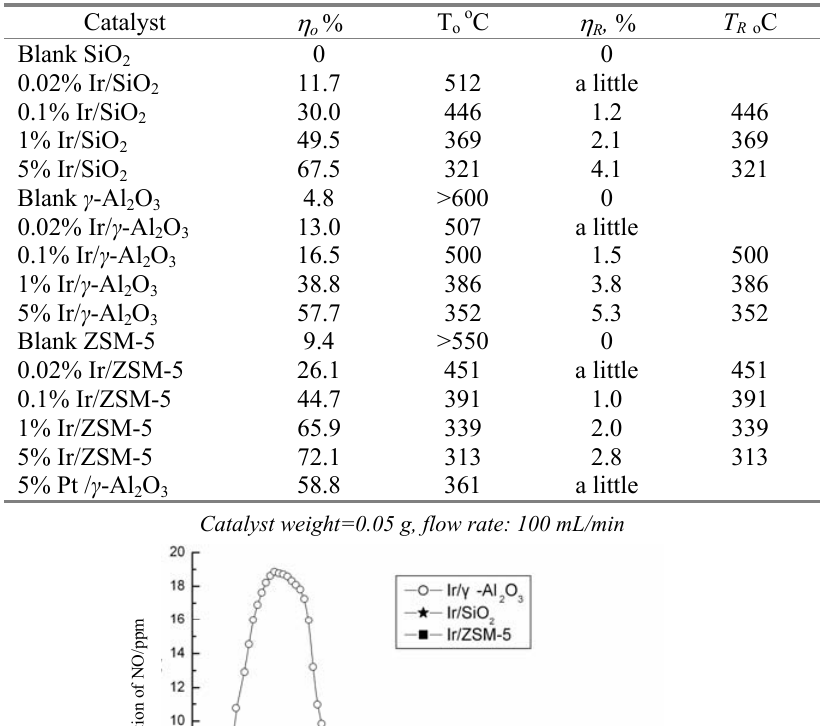
Table 2. Activity of catalysts for NO reaction